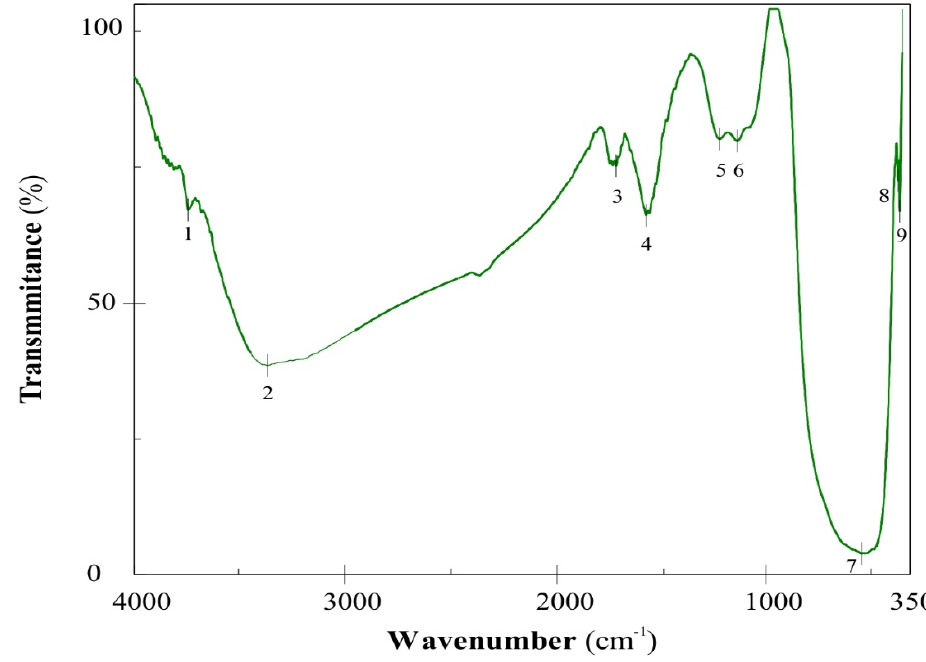
/ IR spectrum of the TiO Figure 3. FT/IR spectrum of the TiO 2 -GO photocatalyst. Figure 3. FT